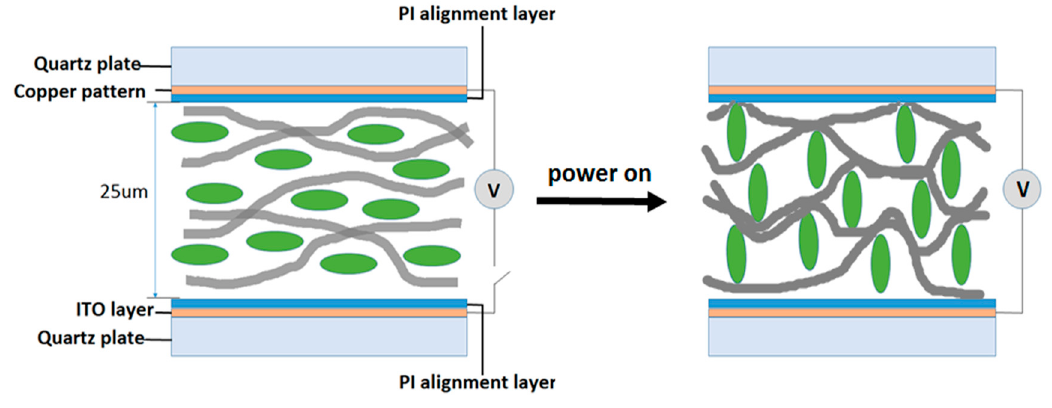
Figure 3. Schematic diagram of the polymer network liquid crystal (PNLC)-based metamaterial absorber (MA).